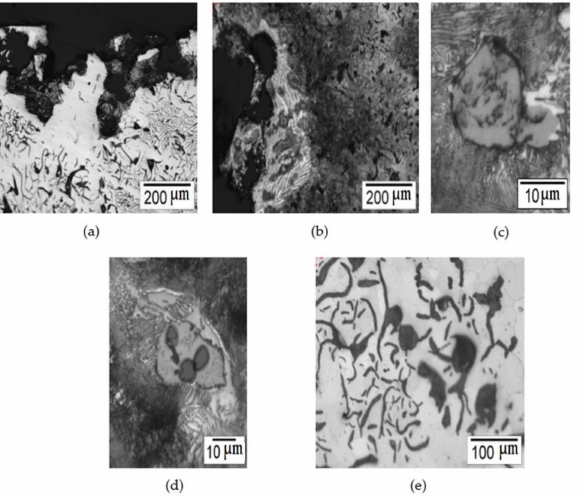
Figure 5. Effects of sulfur in the surface layer of cast samples: ( a , b )-free carbides formation; ( c , d )- formation of complex compounds; ( e )-complex graphite